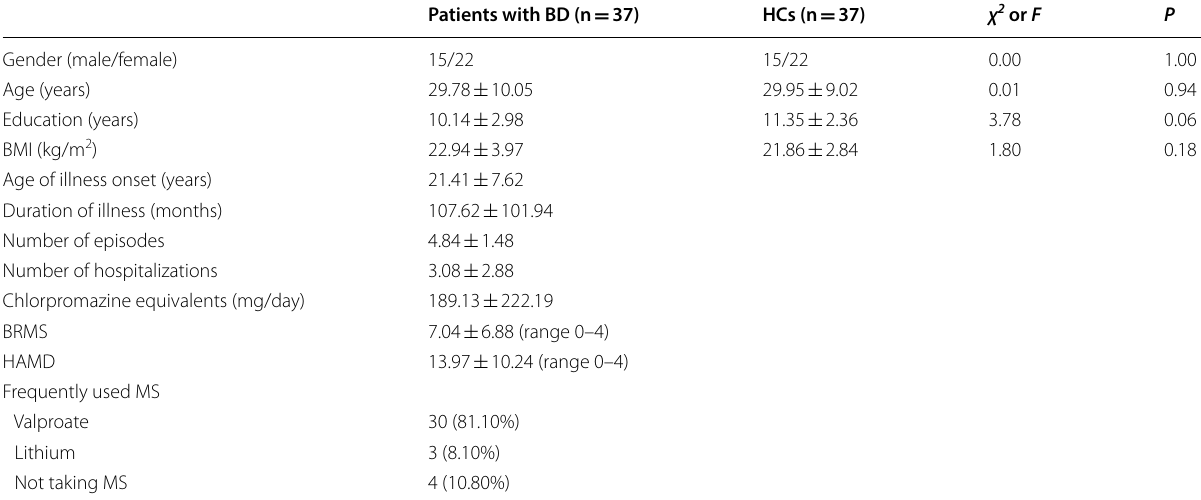
Table 1 Demographic and clinical characteristics in patients with BD and HCs